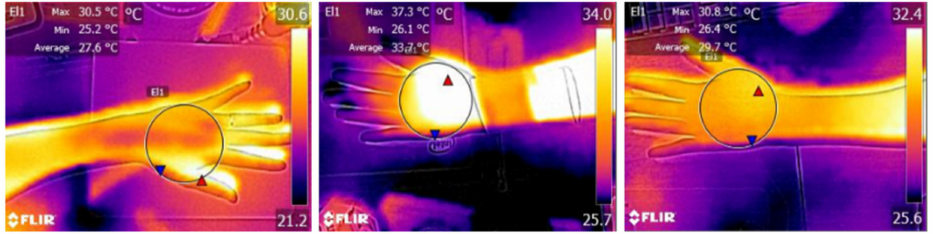
Figure 19. Thermal image of the back of the hand before ( left ), during ( middle ), and after ( right ) SHT